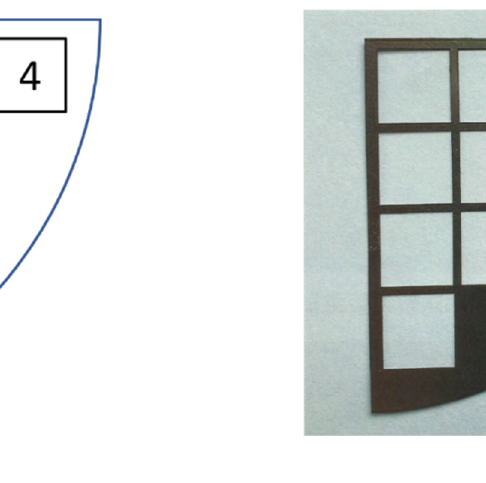
Figure 5. Distribution of the areas of impact of the laser beam for different variants: ( a ) arrangement of 11 test fields on the surface of the sample ( b ) the mask for locating the laser structuring areas. Table 2. Parameters of the eleven variants of the silicone rubber samples modification.